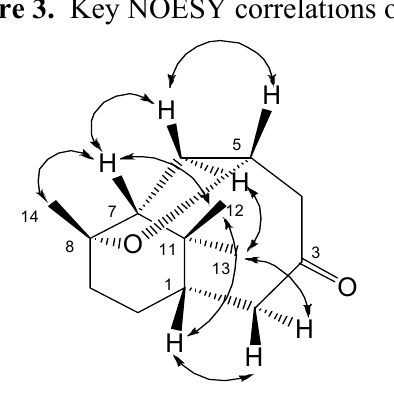
Figure 3. Key NOESY correlations of